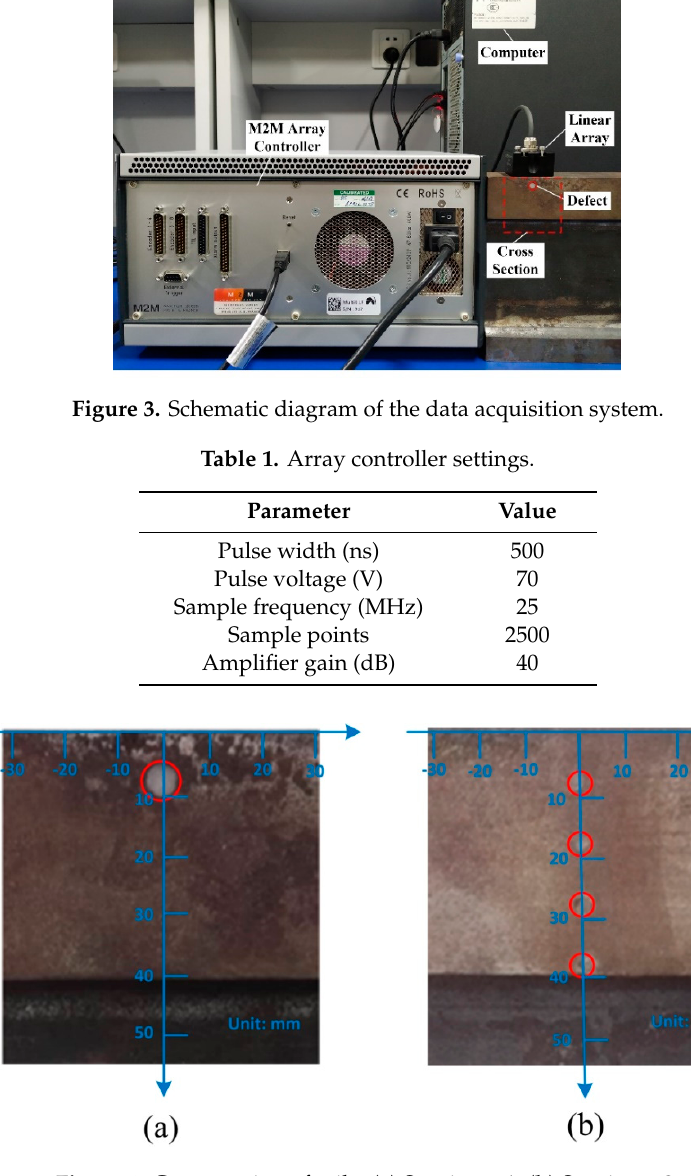
Figure 4. Cross-section of rails: ( a ) Specimen 1; ( b ) Specimen 2.